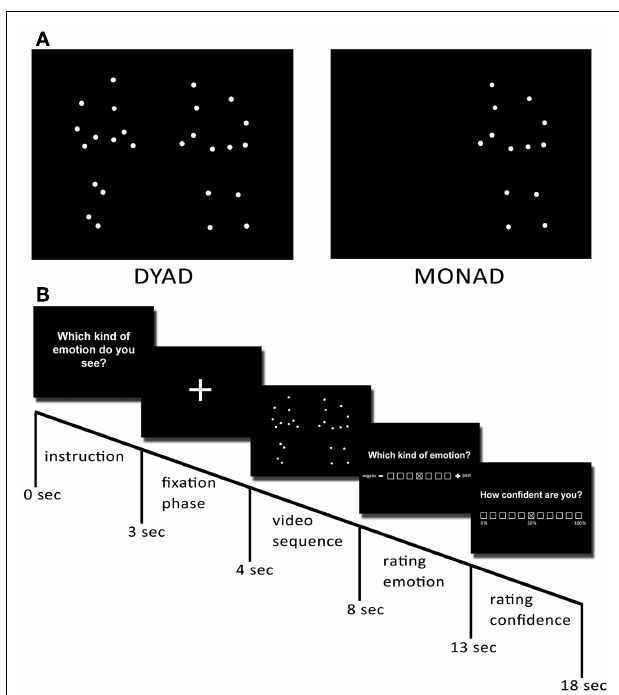
FIGURE 1 | Preparation of stimuli .To create the point-light displays, 13 reflective markers were attached to an actor’s head, shoulders, elbows, wrists, hips, knees, and ankles.They were then tracked using aVicon motion-capture system. (A) Examples of dyadic and monadic point-light displays. (B) Temporal structure of one trial of the